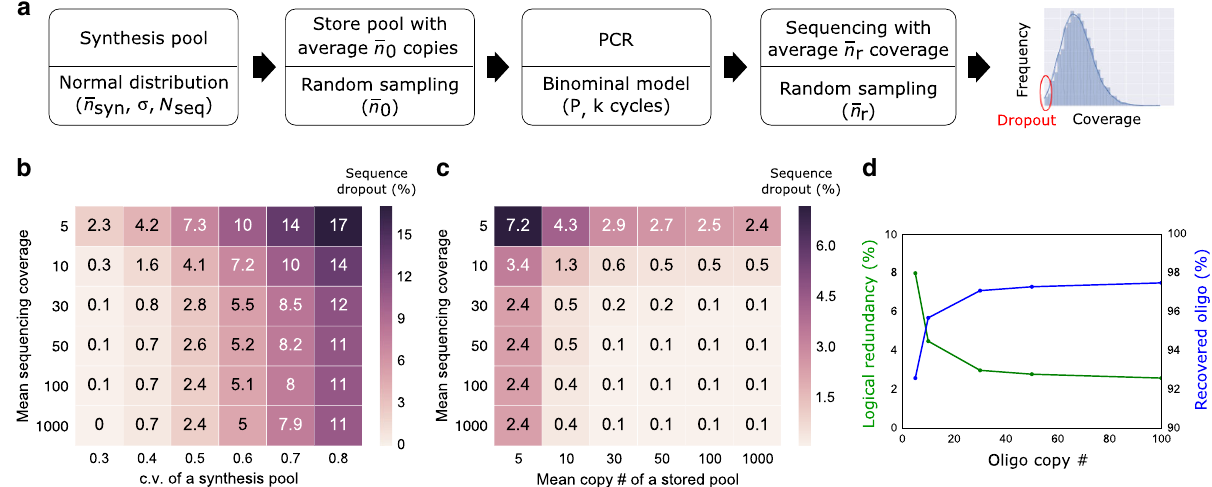
Fig. 6 A computational model can help determine system parameters for DNA data storage. a A synthesis pool was generated with N seq = 10,000 total number of sequences, with normally distributed copy numbers with a mean of (cid:2) n syn = 10 8 and standard deviation σ = 3.2 × 10 7 . The pool was simulated to store an average copy number (cid:2) n 0 = 100, followed by 20 cycles of PCR ampli fi cation with P = 0.95, and high-throughput sequencing with average sequencing coverage (cid:2) n r = 200. Sequence dropout (i.e., coverage of 0 for a given sequence) rates were quanti fi ed. b Sequence dropout percentage as a function of variable synthesis pool c.v. and variable mean sequencing coverage (cid:2) n r . c Sequence dropout percentage as a function of variable mean copy number n 0 and variable mean sequencing coverage (cid:2) n r . d Percentage of recovered oligo and logical redundancy as a function of average oligo copy number. The mean sequencing coverage is 5. When a very low copy number of oligo is stored, more sequences drop out, and thus higher logical redundancy is needed. The reported dropout percentage was the average of 100 repeated